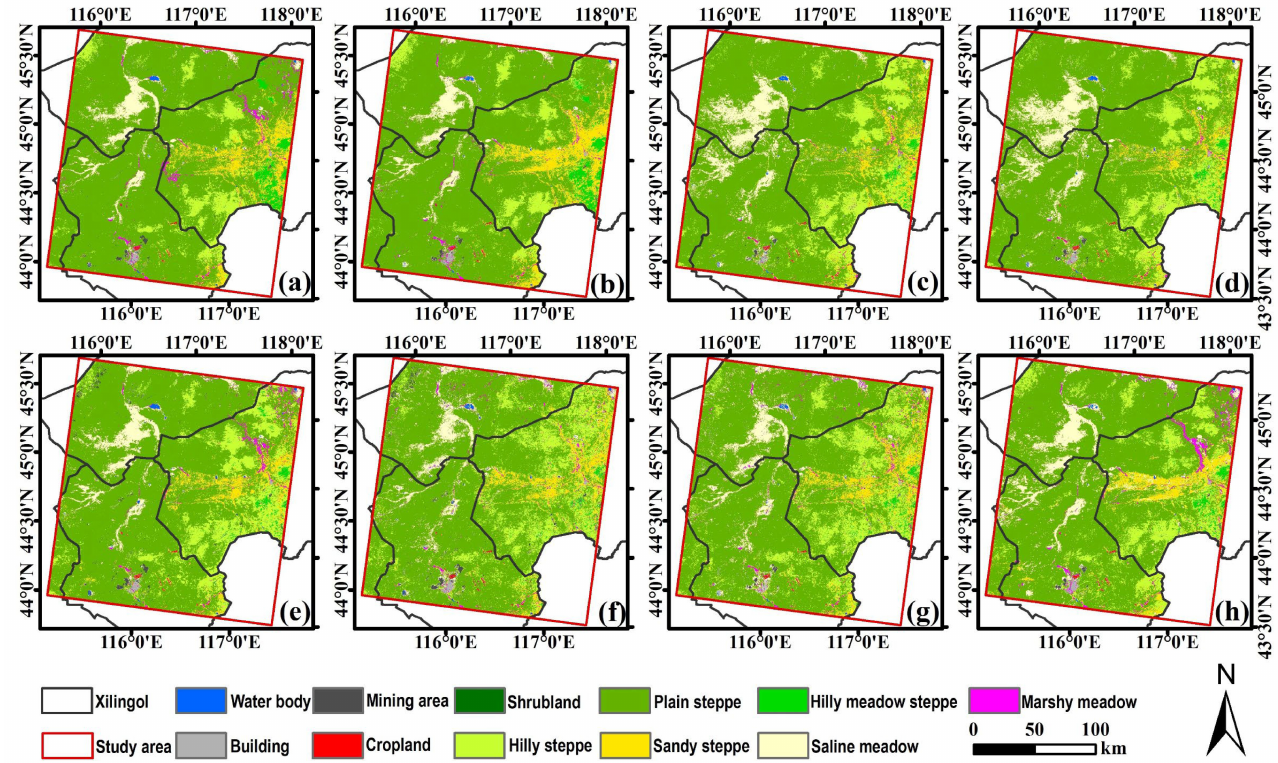
Figure 9. Comparison of pixel-based and object-based classification results: ( a ) pixel-based RF; ( b ) pixel-based SVM; ( c ) pixel-based KNN; ( d ) pixel-based NB; ( e ) object-based RF; ( f ) object-based SVM; ( g ) object-based KNN; ( h ) object-based NB.